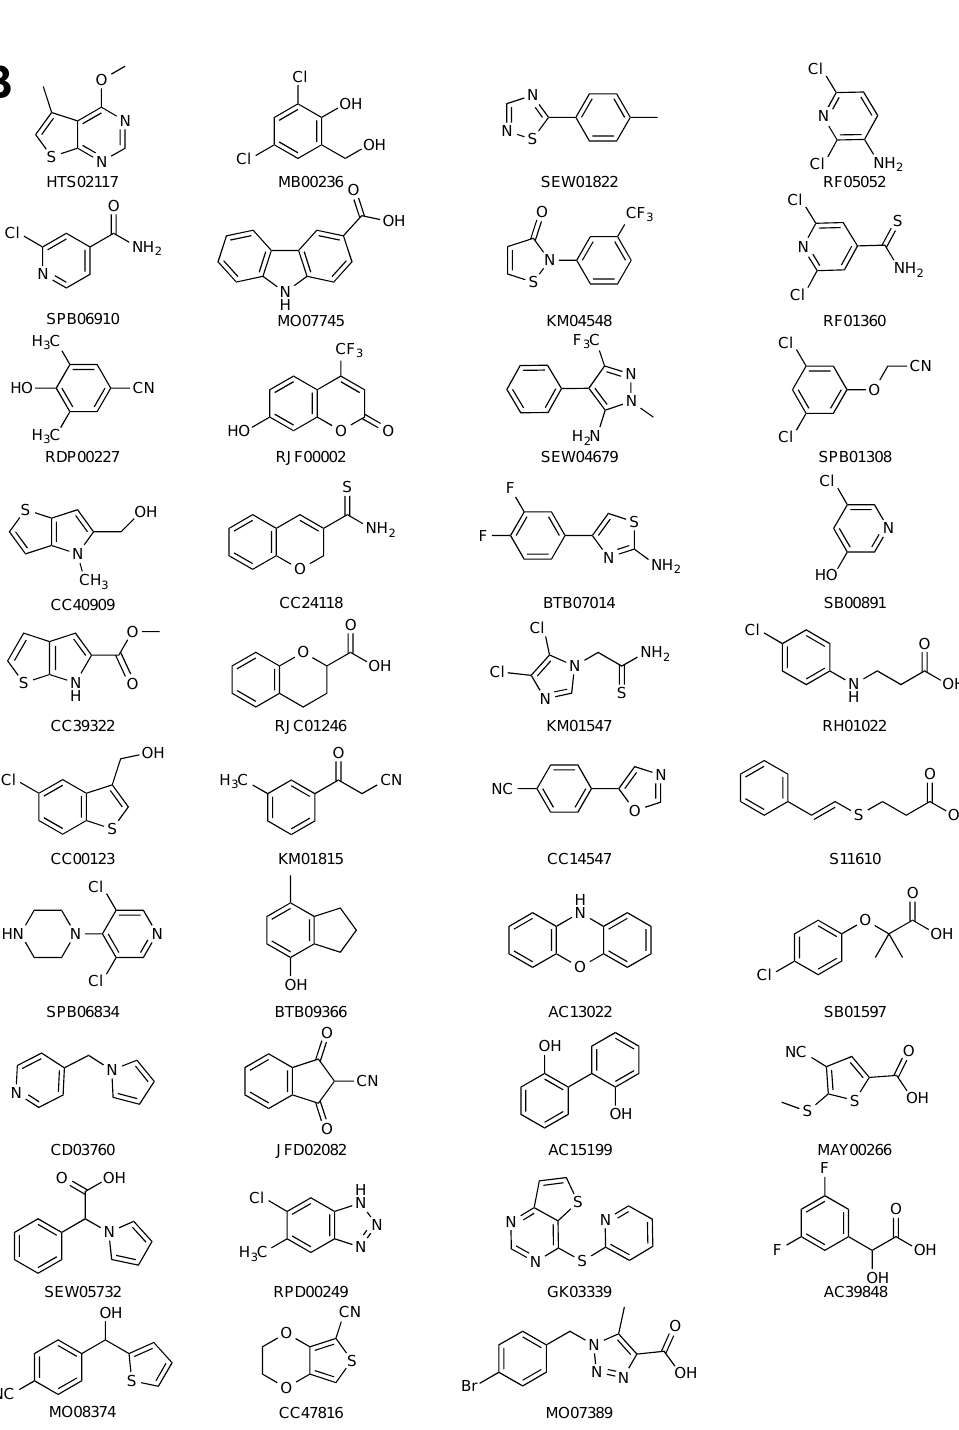
Figure 2. Validated fragment hits from the NMR-STD screen. ( A ) Structures of the validated EBNA1 fragment hits. ( B ) Structures of the validated LANA fragment hits.